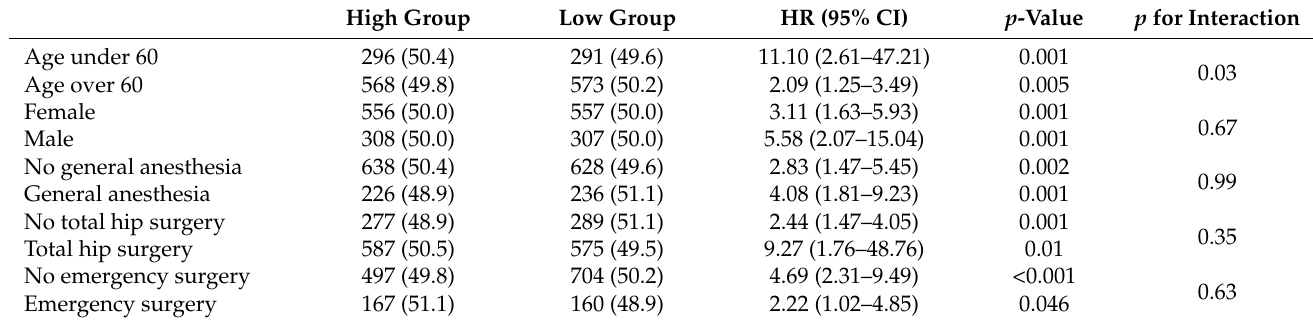
Table 4. Subgroup analysis for association between one-year mortalities and days alive and out